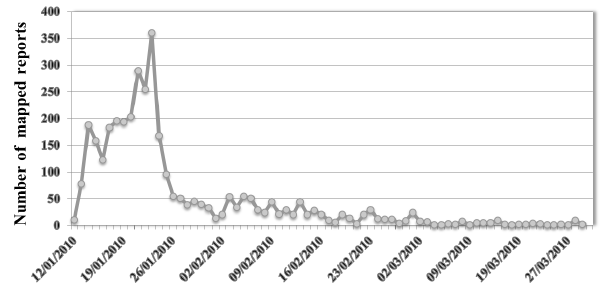
Figure 2. Number of crisis reports recorded daily between the January 12 and 30 March 2010 8 Fig. 2. Number of crisis reports recorded daily between 12 January and 30 March